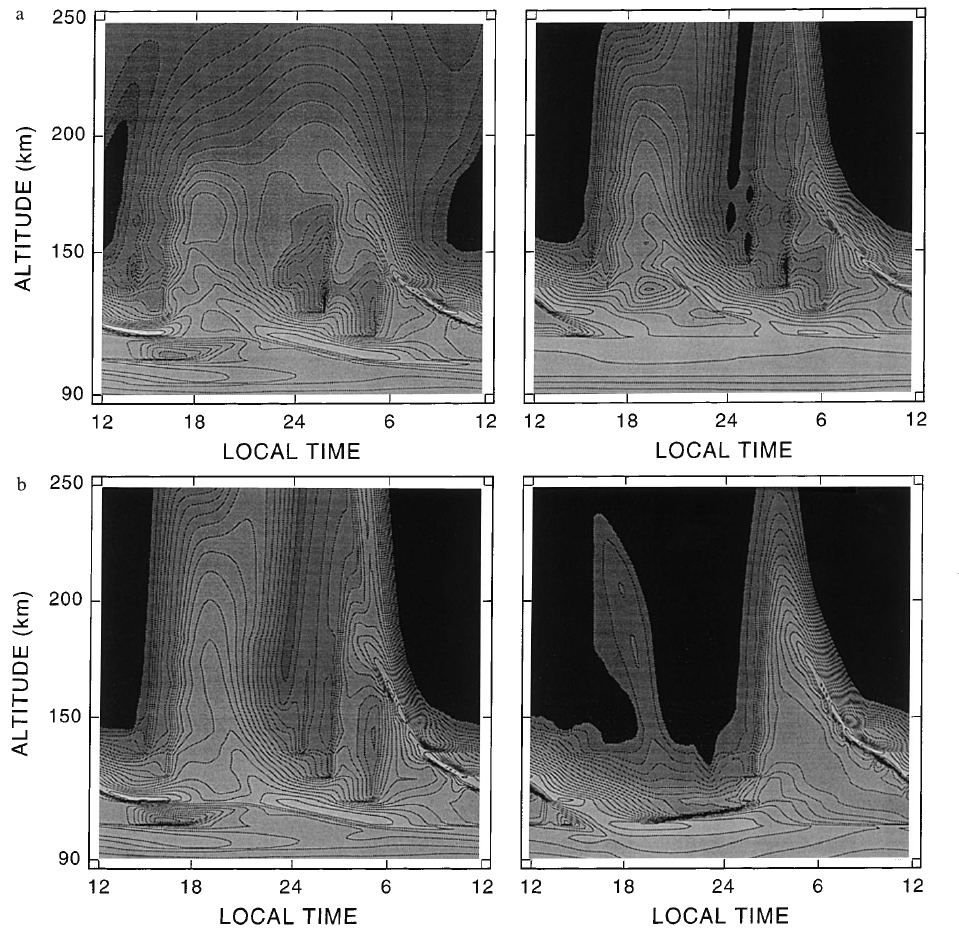
Fig. 6a. (top panels) Height versus local time contours of log [Fe + ] at 18 (cid:176) latitude from 10 the 1-D version of the model, and driven by vertical drifts due to zonal winds only ( left panel ) and meridional winds only ( right panel ). Minimum contour is 6.0 ( black ) and maximum contour is 12.0 ( white ), with spacing 0.25 and concentrations given in m ) 3 . b (bottom panels) Height versus local time contours of log [Fe + ] at 18 (cid:176) latitude from 10 the 1-D version of the model, and driven by vertical drifts due to zonal and meridional winds ( left panel ) and electric fields in addition to zonal and meridional winds ( right panel ) others details as in